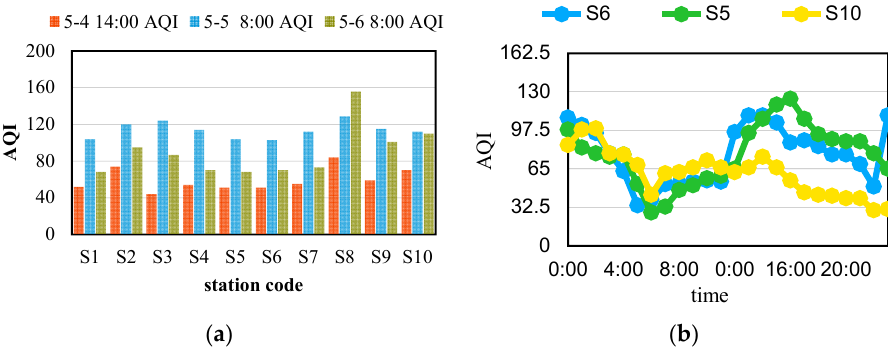
Figure 2. ( a ) AQI Samples in Shenyang; ( b ) AQI Trend on 12 May 2015 in Shenyang.